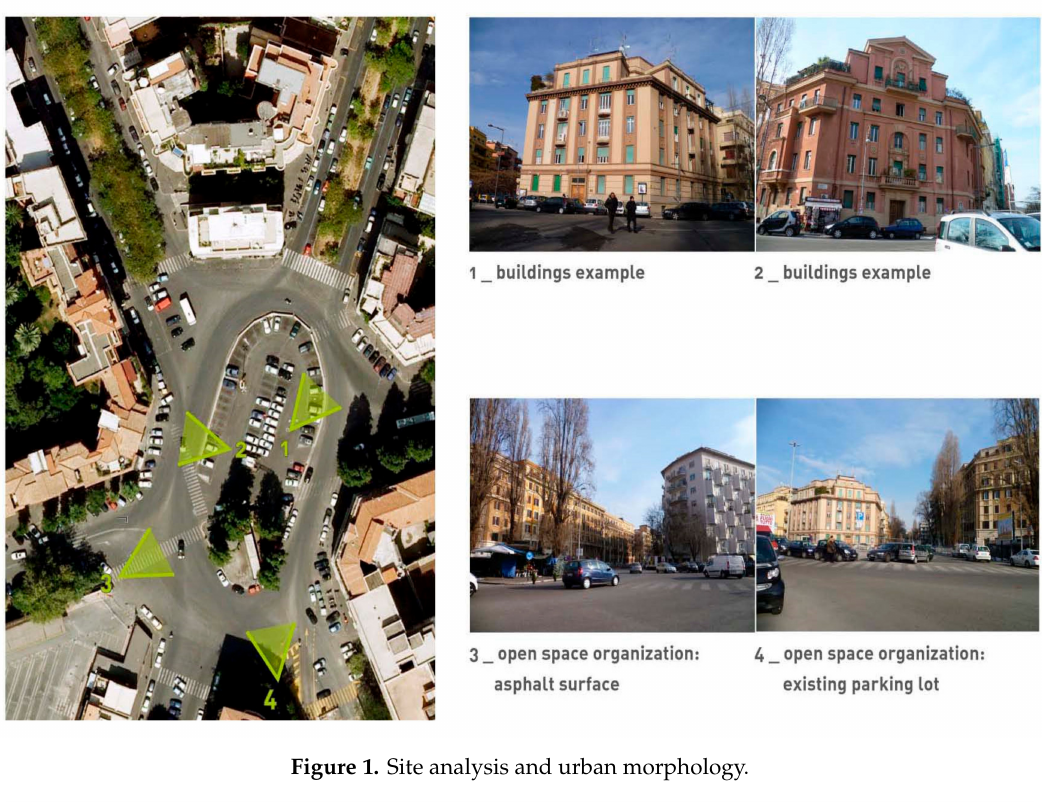
Figure 1. Site analysis and urban morphology.